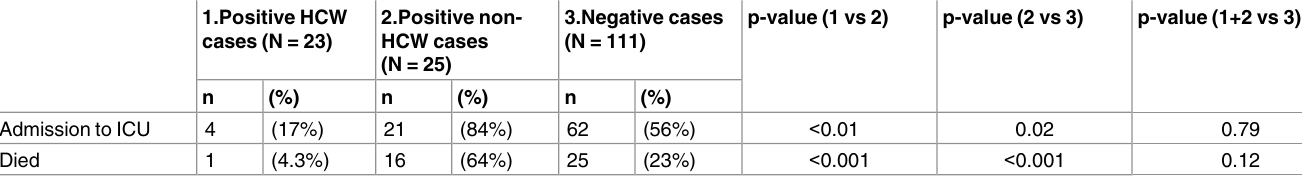
Table 5. Comparison of poor outcome among three patient